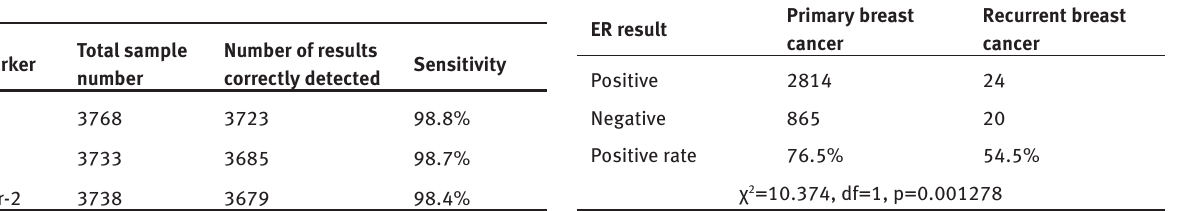
Table 1: Summary of results of the extraction of immunohistochemi- cal study result data.